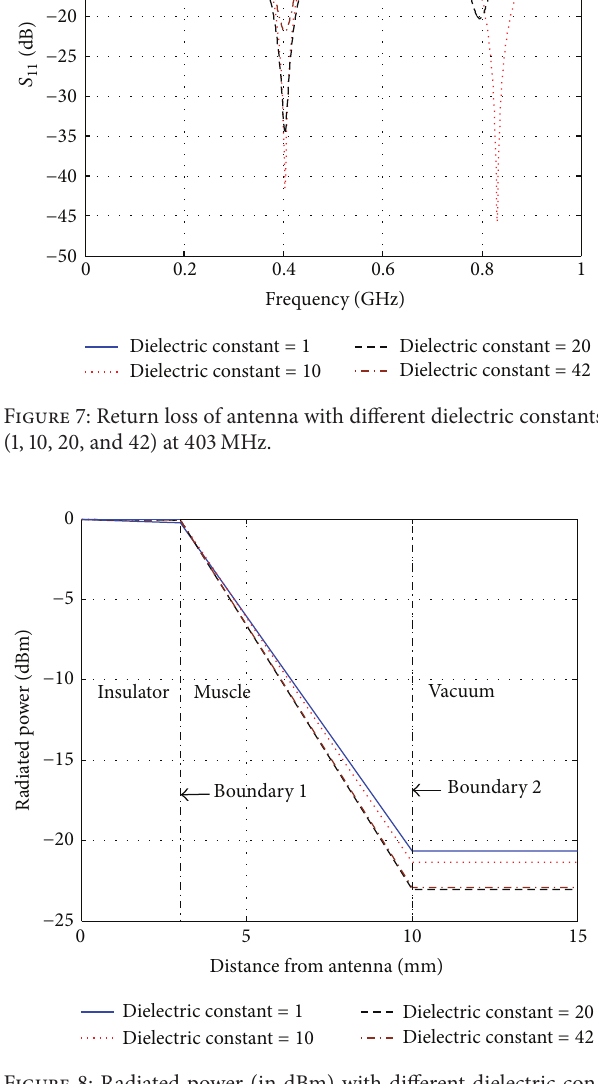
Figure 8: Radiated power (in dBm) with different dielectric con- stants (1, 10, 20, and 42) at 403 MHz; input power = 1mW. Table 1: Design parameters (in mm) of embedded loop